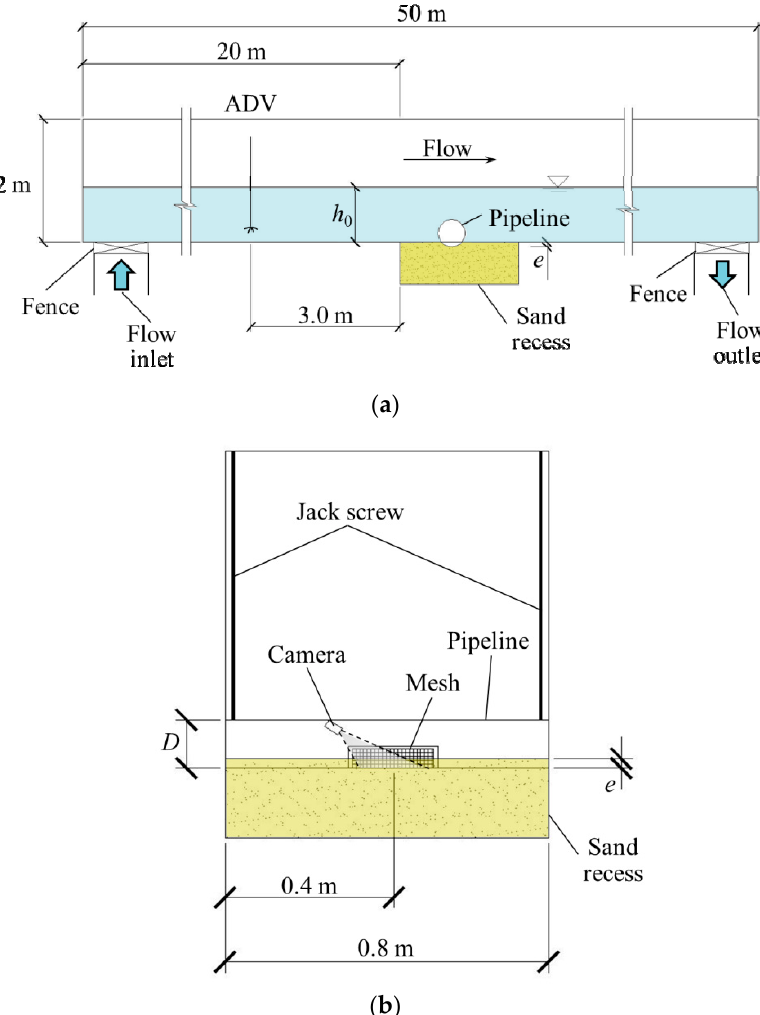
Figure 2. Experimental setup (not to scale): ( a ) Experimental flume (side view); ( b ) setup of model pipeline (cross-section view). Symbols: h 0 = flow depth; e = pipeline embedment depth; D = pipeline diameter.